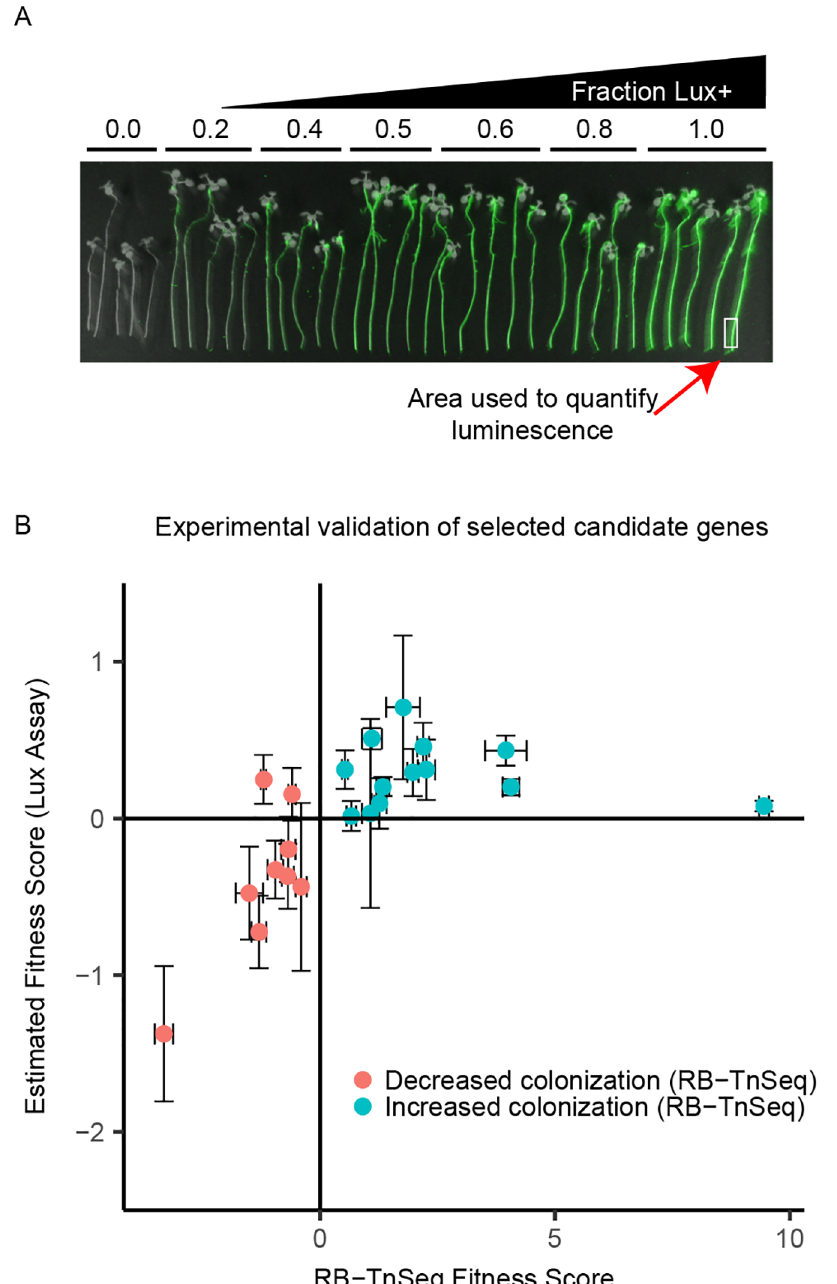
Fig 3. Selected candidates are validated using secondary luciferase-based screen. Twenty-two mutant strains were retrieved from an arrayed clone library for further validation.These strains were competed againstan engineeredwild-type(WT) P . simiae strain that produces luciferase. (A) False-colorimage of competitionbetweenthe nonengineered WT WCS417r strain versus the luciferase-producing(Lux+) strain. Each group of 5 roots representsa different ratio of Lux+ to WT (0.0–1.0). Luminescence intensity is false colored in green. White rectangleindicatesapproximate regionof the root tip used to measureluciferase activity. (B) All 22 insertionmutant strains (describedin S1 Data) were competedwith the Lux+ on roots and empty phytagel/mesh plates after inoculationas a 1:1 mixture. A ratio of each mutant strain to the Lux+ strain on the roots was estimated by interpolating the luminescenceintensity of the root tip onto a standardcurve (S5 Fig, S1 Data). The estimated fitness score (Lux+ colonization index [CI] in S1 Data) was then derived from the log-transformed root ratio minus the log-transformed mesh (no root final [NRF]) ratio (see S1 Data). Error bars are ± standard error ( n = 3 biological replicates for y-axis, n = 15 for x-axis). Abbreviation: RB-TnSeq, randomly barcodedtransposon mutagenesis